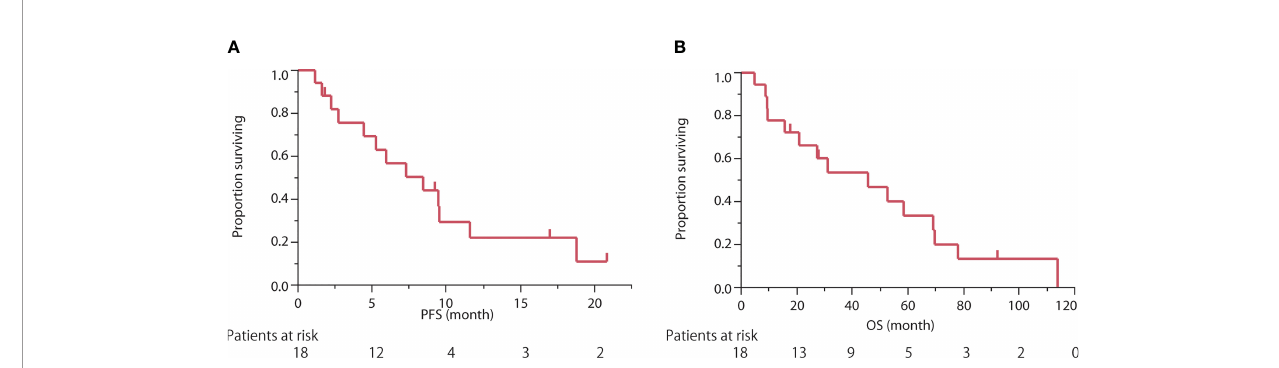
FIGURE 1 | (A) Swimmer ’ s plot of progression-free survival in individual patients at each chemotherapeutic line. (B) Change in tumor size from baseline (%) in thymic carcinoma patients treated with the cisplatin and irinotecan combination regimen as the fi rst-line chemotherapy. TC, carboplatin and paclitaxel; GV, gemcitabine and vinorelbine; DOC, docetaxel; AMR, amrubicin; CPT-11, irinotecan; PEM, pemetrexed; ADOC, cisplatin, doxorubicin, vincristine, and cyclophosphamide; GEM, gemcitabine; CBG, carboplatin and gemcitabine; CA, cisplatin and adriamycin; PE, cisplatin and etoposide.